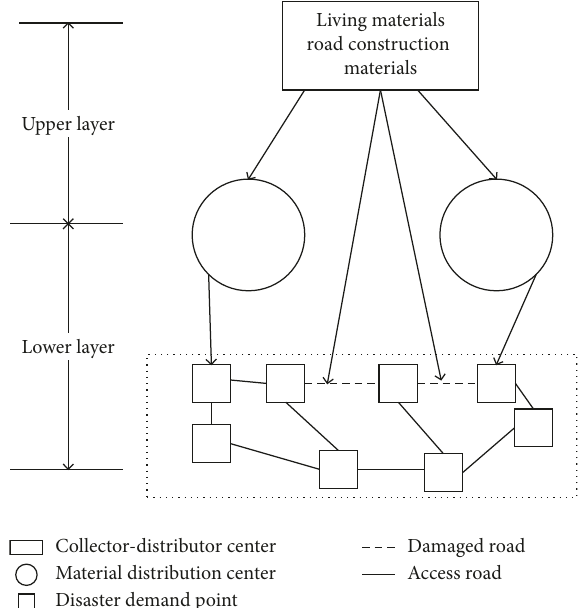
Figure 2: Schematic diagram of double-layer emergency logistics after